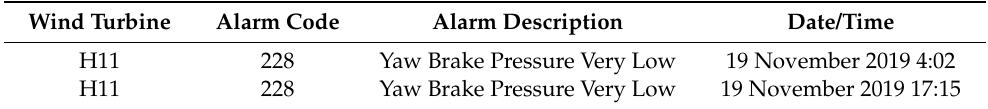
Table 5. Part of the SCADA alarm system corresponding to anomalies for H11.